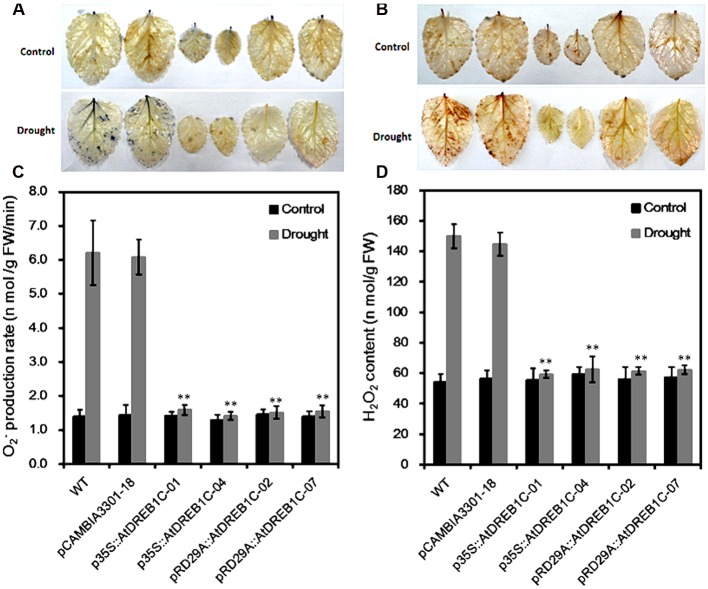
Changes in O2- (A,C) and H2O2
(B,D) levels in wild-type (WT) and transgenic leaves from plants subjected to drought stress. Drought-stressed leaves were incubated in nitroblue tetrazolium (NBT) or diaminobenzidine (DAB) solution. Blue staining indicates the location and levels of O2-
(A). Brown staining indicates H2O2 accumulation (B). O2- production rate (C) and H2O2 content (D) were measured after drought treatment. The labels under the graphs correspond to the plant materials shown in (A) and (B). Control, plants growing under normal conditions; Drought, plants growing after drought stress treatment (6 days). WT, wild type. The transgenic lines are indicated by the construct names followed by the line number: p35S::AtDREB1C-01 refers to p35S::AtDREB1C line 01 and so on; pCAMBIA3301-18 was used for the positive control. Bars represent the mean + SE of three independent experiments. ∗∗Significantly different at the P < 0.01 level compared to WT.